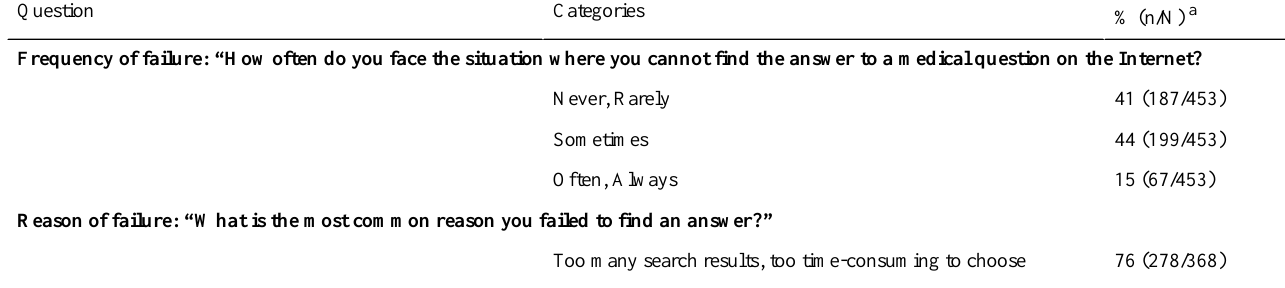
Table 4. Overall frequency, reason, and consequence of failure to retrieve medical information from the Internet. Frequency of failure: “How often do you face the situation where you cannot find the answer to a medical question on the